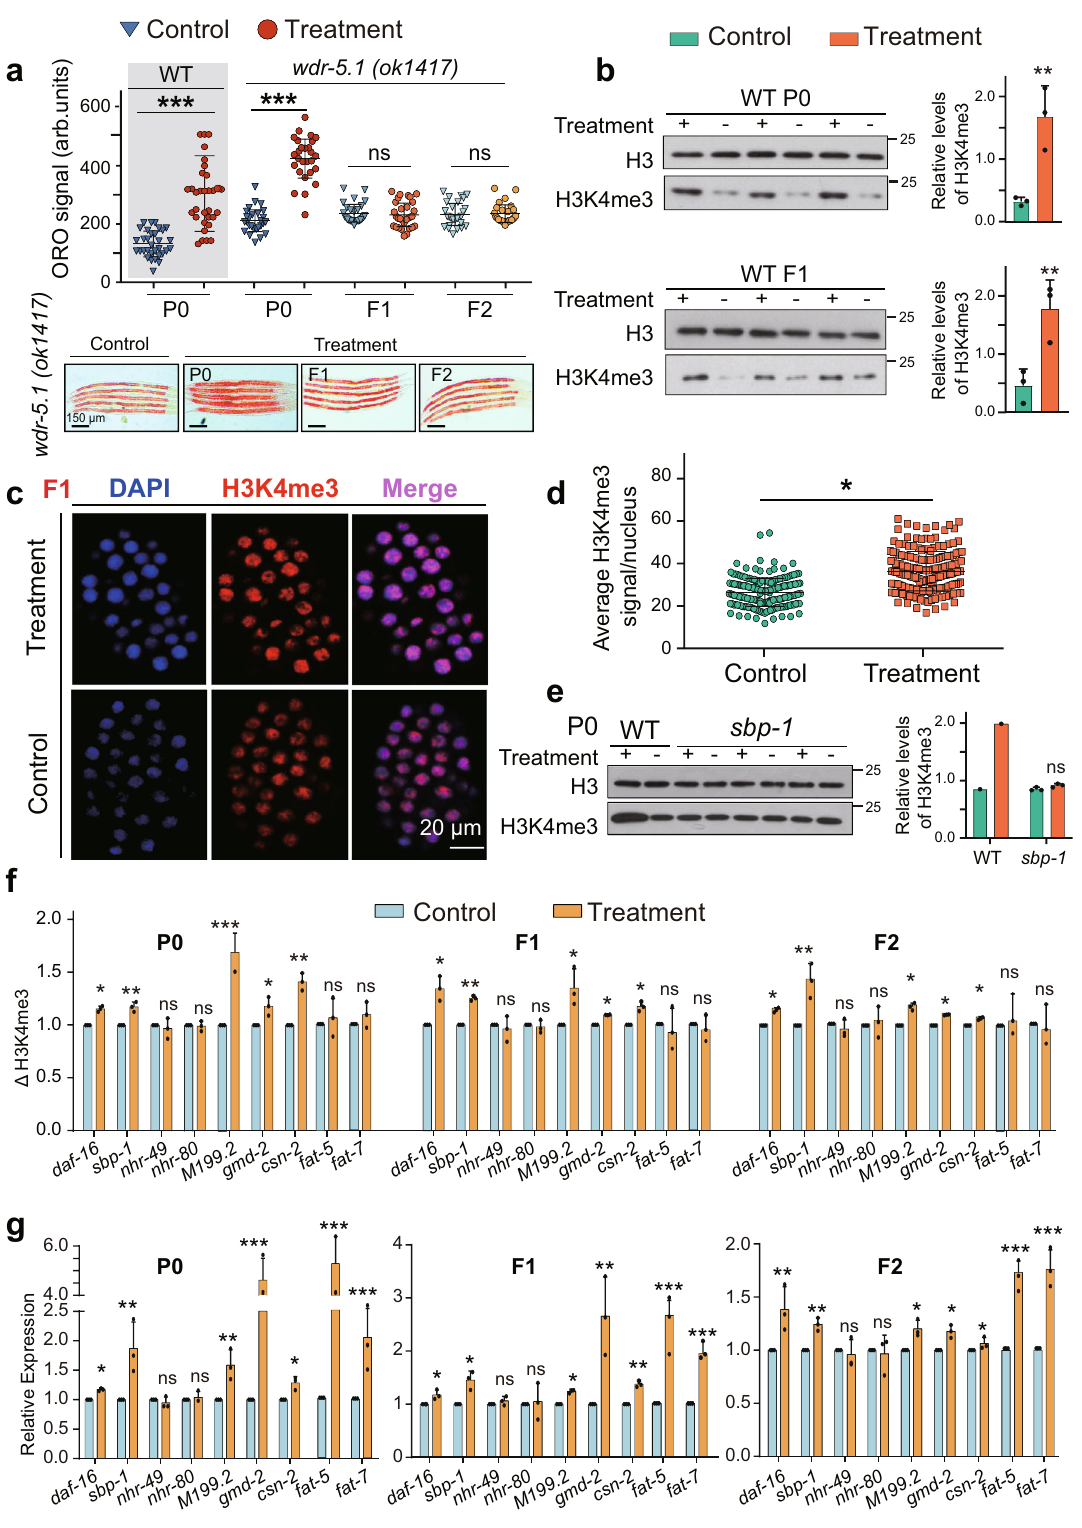
Conditions for inducing lipid accumulation . To induce lipid accumulation, ~500 synchronized L1 larvae were raised on NGM plates with or without HFD. To obtain F1 generation worms, gravid day 1 adults treated with or without HFD were bleached and hatched overnight in 10mL M9 buffer, and subsequently grown on NGM plates without HFD. This process was repeated to obtain the Fn generations. For worms fed with HFD until L4 larvae, synchronized L1 larvae were grown on NGM plates with HFD until L4 larvae, then transferred them to NGM plates with normal food, Fn generations animals were obtained using the similar protocol mentioned above.